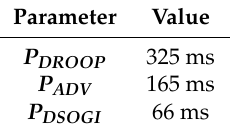
Table 3. Settling time simulation measurements from Figure 15.